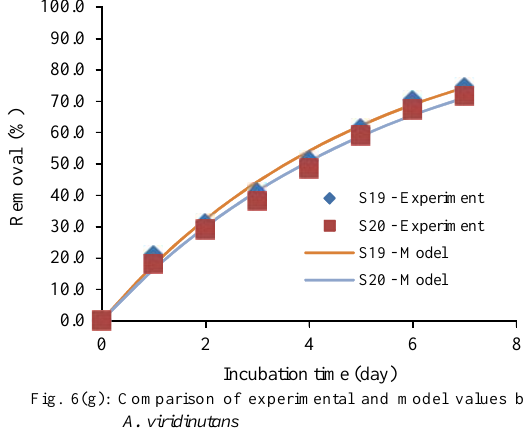
Fig. 6(g): Comparison of experimental and model values by A. viridinutans Fig. 6 (a to g): The comparison of experimental observed values with biosorption model calculated values for different incubation time with an optimum pH of 3, optimum biomass (isolated fungi species) of 4.0 g of each fungus and